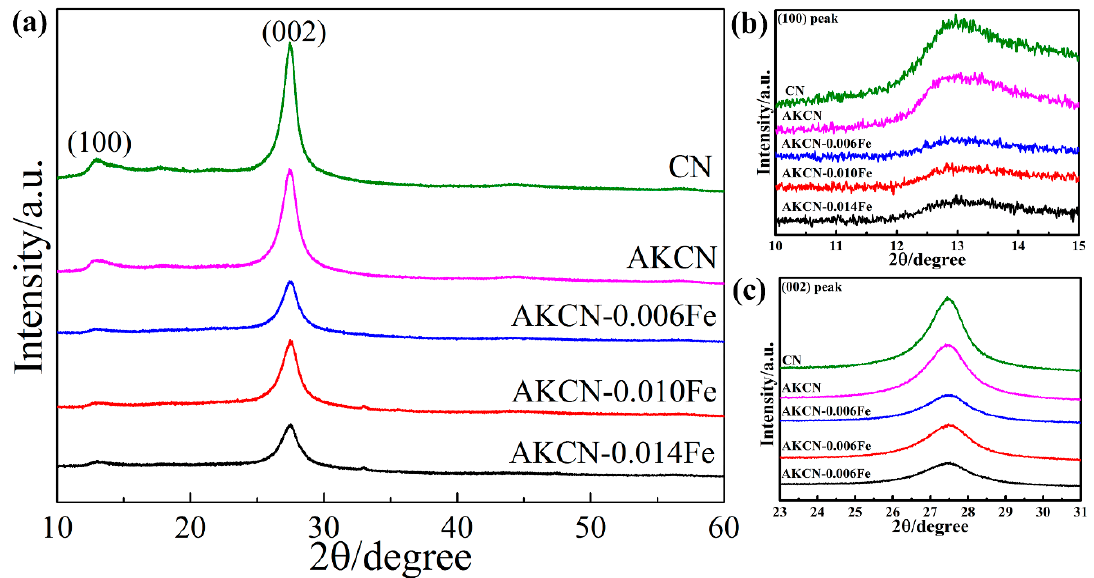
Figure 2. ( a ) XRD patterns of the synthesized semiconductor photocatalysts, and enlarged view of ( b ) (100) peak and ( c ) (002) peak.